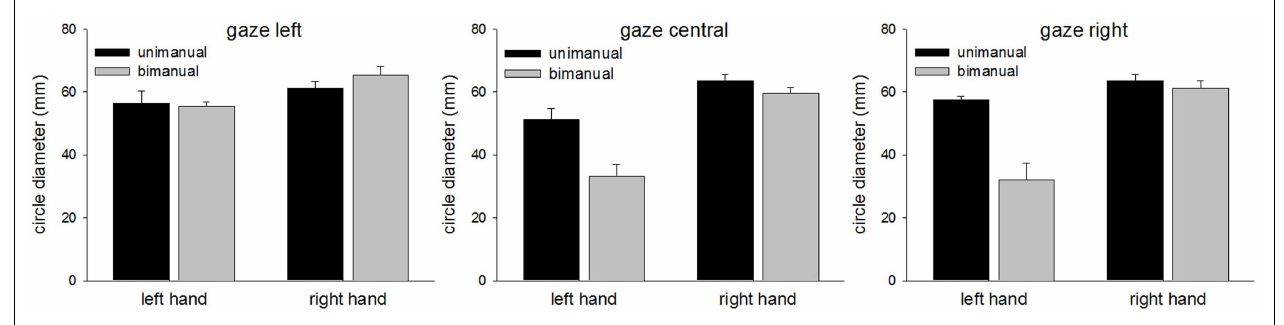
FIGURE 5 | Circle diameters for each condition in Experiment 2 .